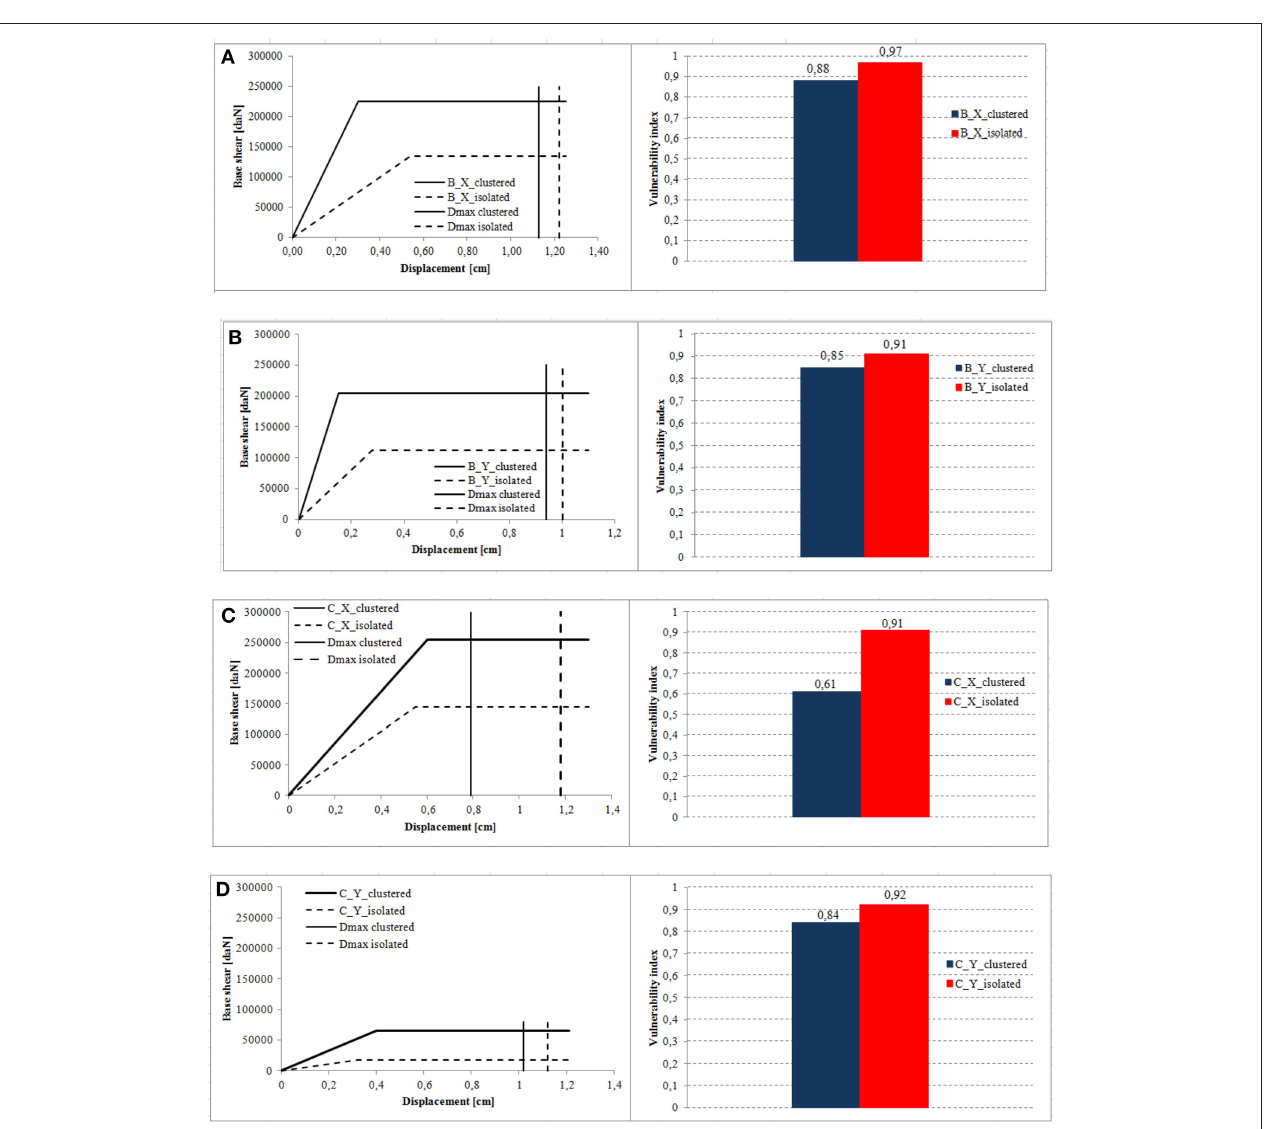
FIGURE 12 | Pushover curves and comparison in terms of vulnerability indices for S.U. 8B in directions X (A) and Y (B) and for S.U. 8C in directions X (C) and Y (D) .